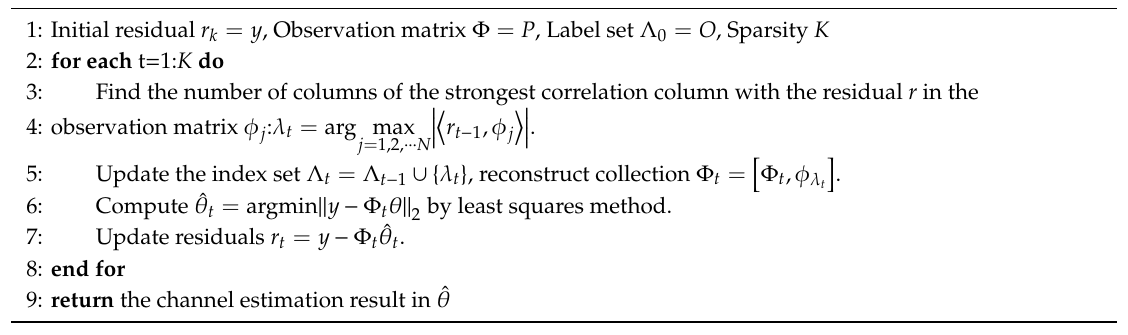
Algorithm 1 Orthogonal matching pursuit